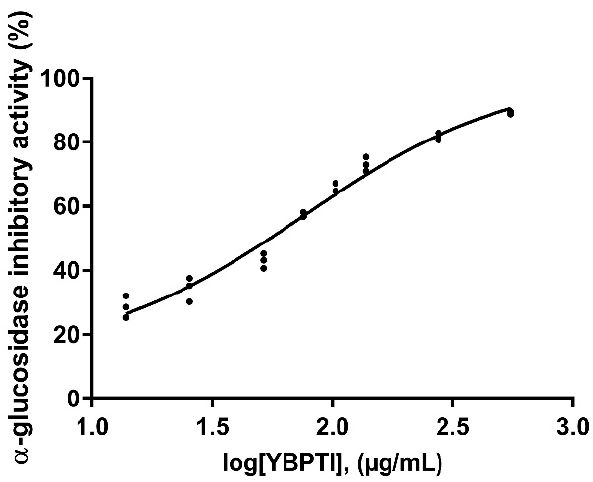
Figure 5. Effect of YBPTI on the α -glucosidase activity. YBPTI showed a concentration-dependent